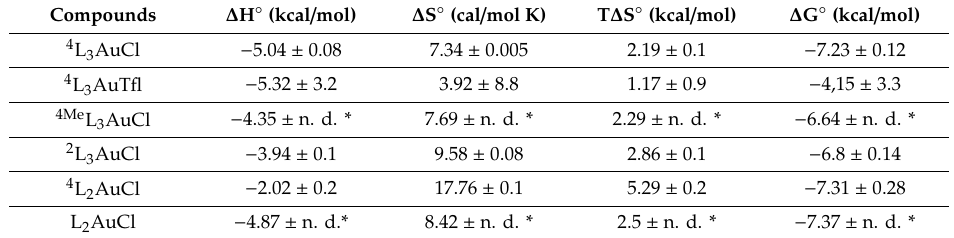
Table 3. Thermodynamic data for tris and bisphosphane gold complexes.